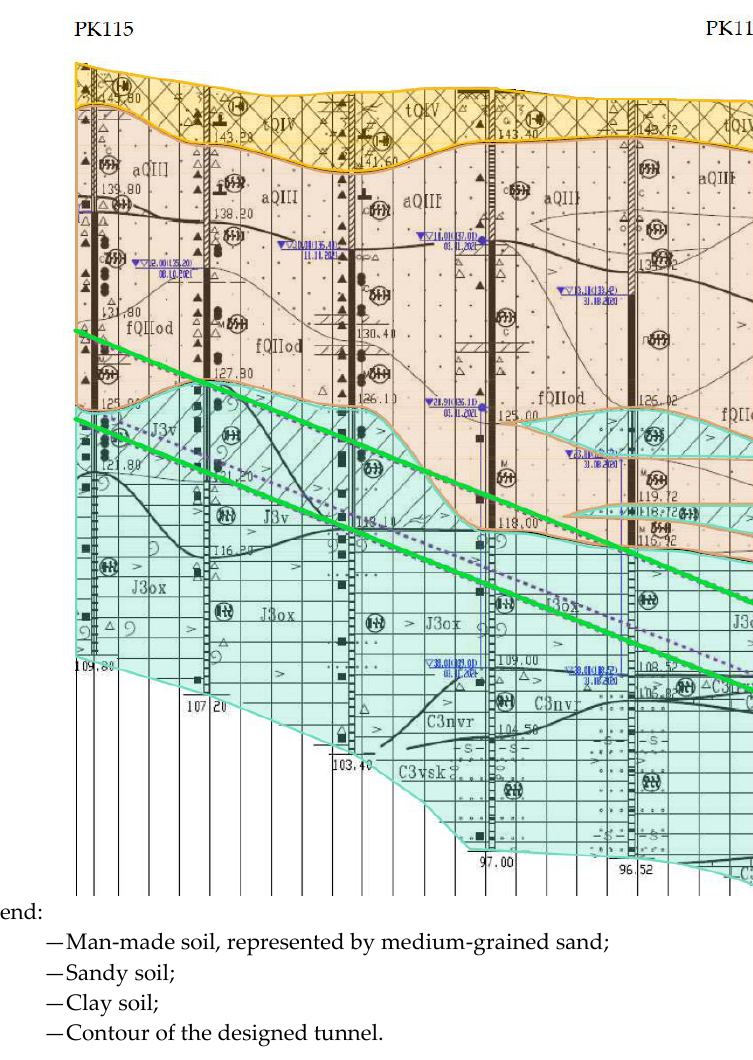
Figure 1. Fragment of the lefthand tunnel, section PK111-PK115.